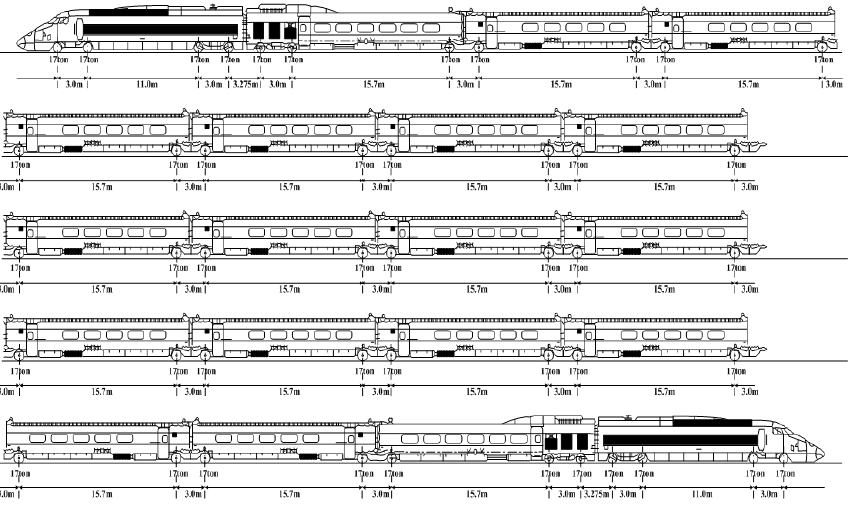
Figure 7. Korea Train Express (KTX) wheel composition [35].